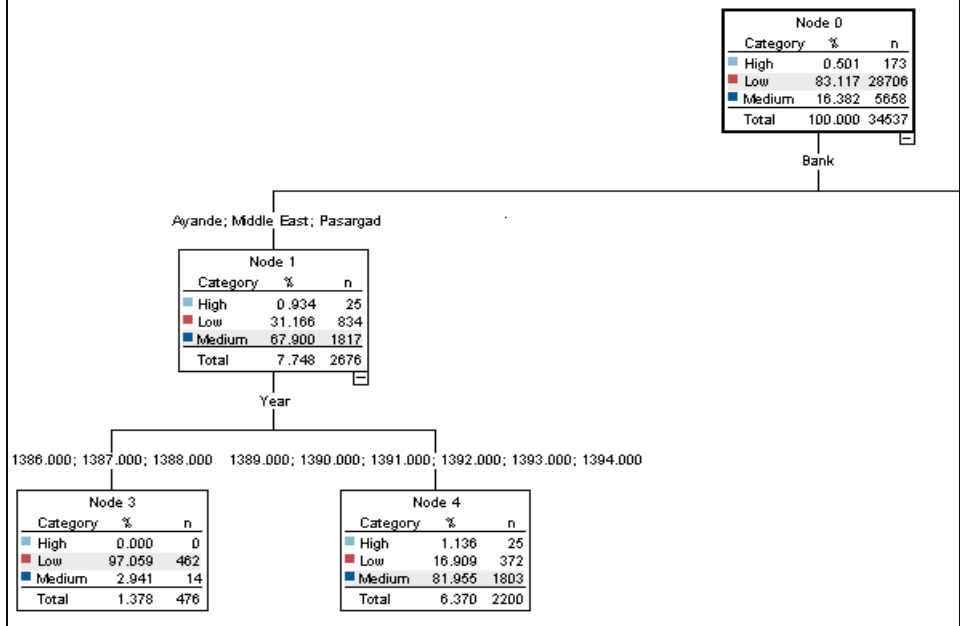
Figure 6. Branch of rules 5 and 6.